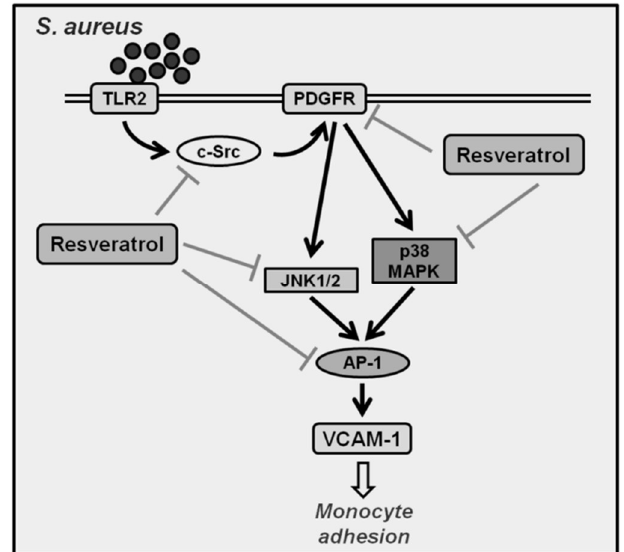
Figure 8. Schematic diagram illustrating the proposed signaling pathway involved in S. aureus -induced VCAM-1 expression in HPAEpiCs. S. aureus induces JNK1/2 and p38 MAPK activation via a c-Src/PDGFR pathway, which in turn initiates the activation of AP-1. Activated AP-1 is recruited to the promoter regions of VCAM-1, leading to an increase of VCAM-1 promoter activity and the expression of VCAM-1 mRNA and protein in HPAEpiCs. Moreover, resveratrol can reduce lung inflammation via the inhibition of VCAM-1 expression, monocyte adhesion, and the activation of c-Src, PDGFR, JNK1/2, p38 MAPK, and AP-1 induced by S. aureus .